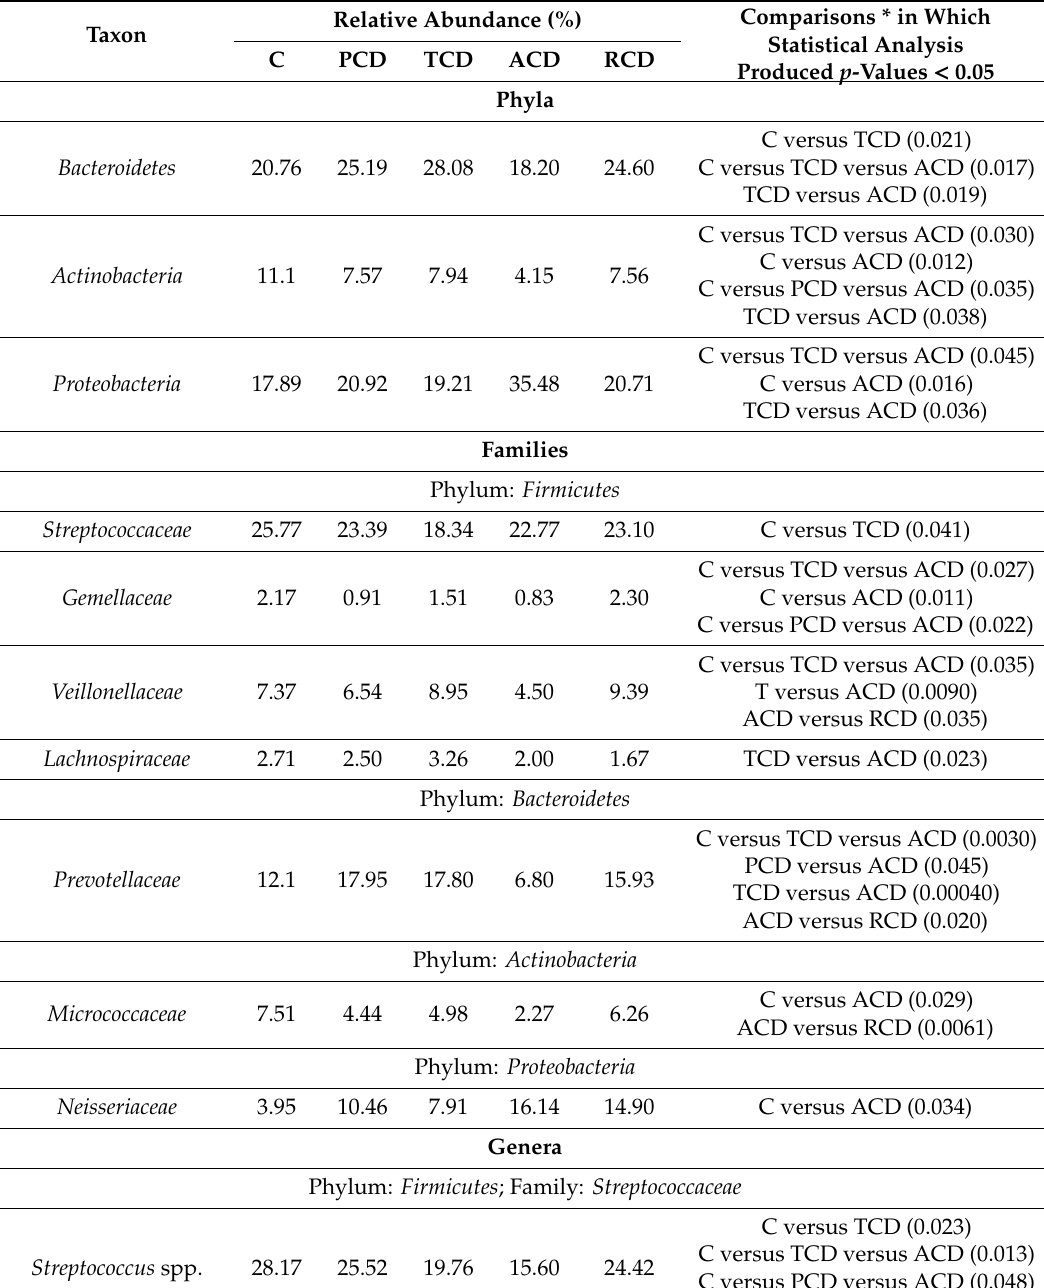
Table 3. Taxa displaying significantly di ff erent relative abundances in mucosal biopsies.